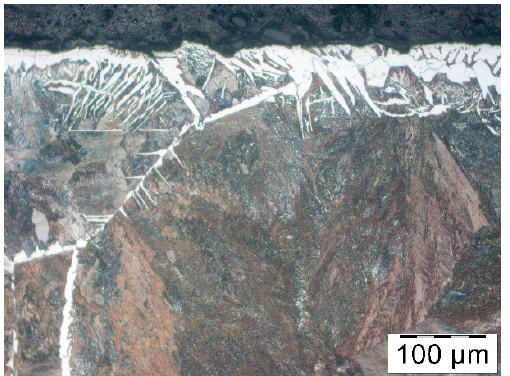
Figure 8. Microstructure of the surface layer of the steel bar C45 after induction heating, coated in Condursal—concentration 100%.